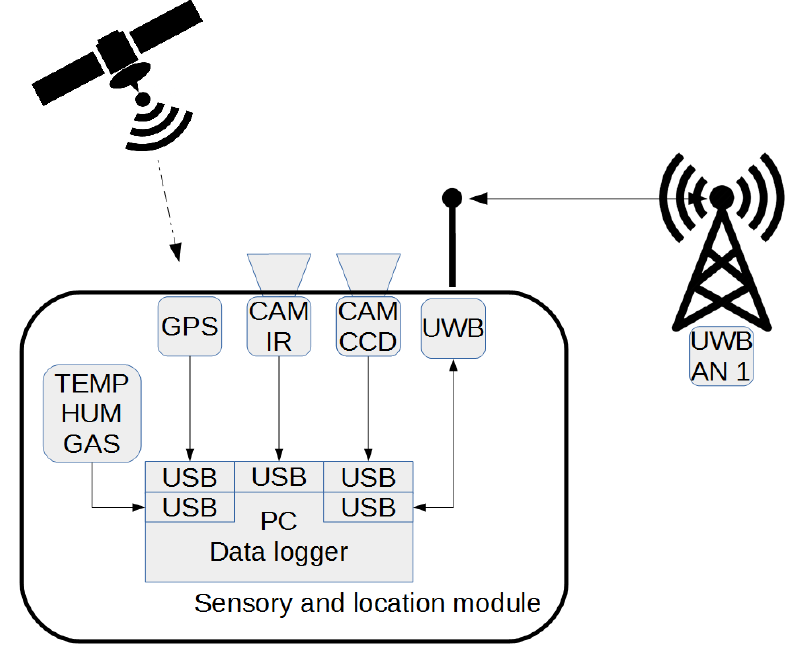
Figure 11. Sensory and location